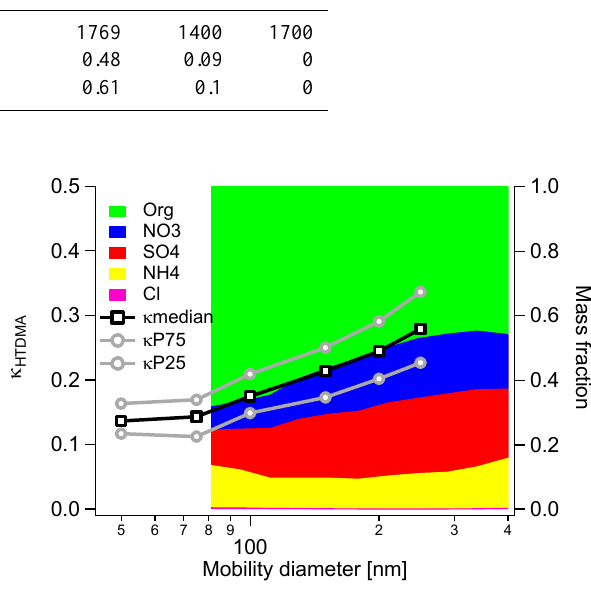
Fig. 3: Comparison between the size-resolved hygroscopicity parameter  and the size- 767 Fig. 3. Comparison between the size-resolved hygroscopicity pa- segregated mass fractions of non-refractory compounds during HCCT-2010. 768 rameter κ and the size-segregated mass fractions of non-refractory compounds during